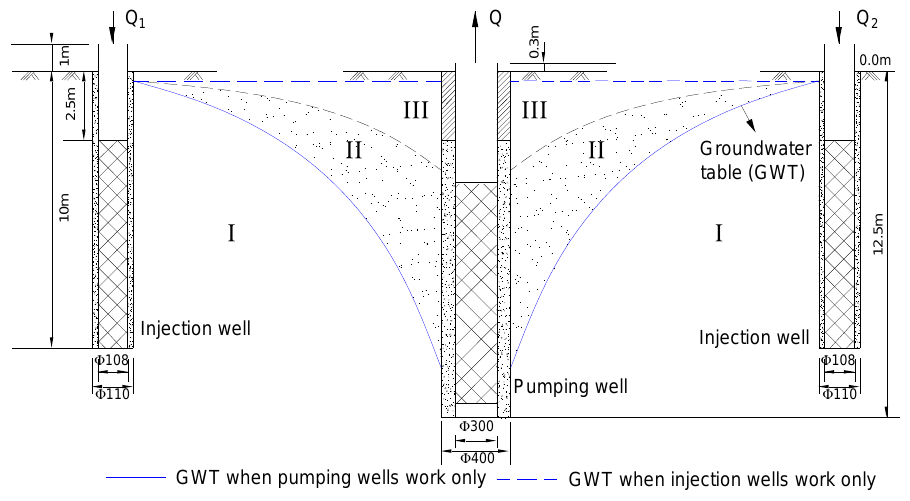
Figure 6. Structure of injection and pumping well, and water level distribution under different working conditions.